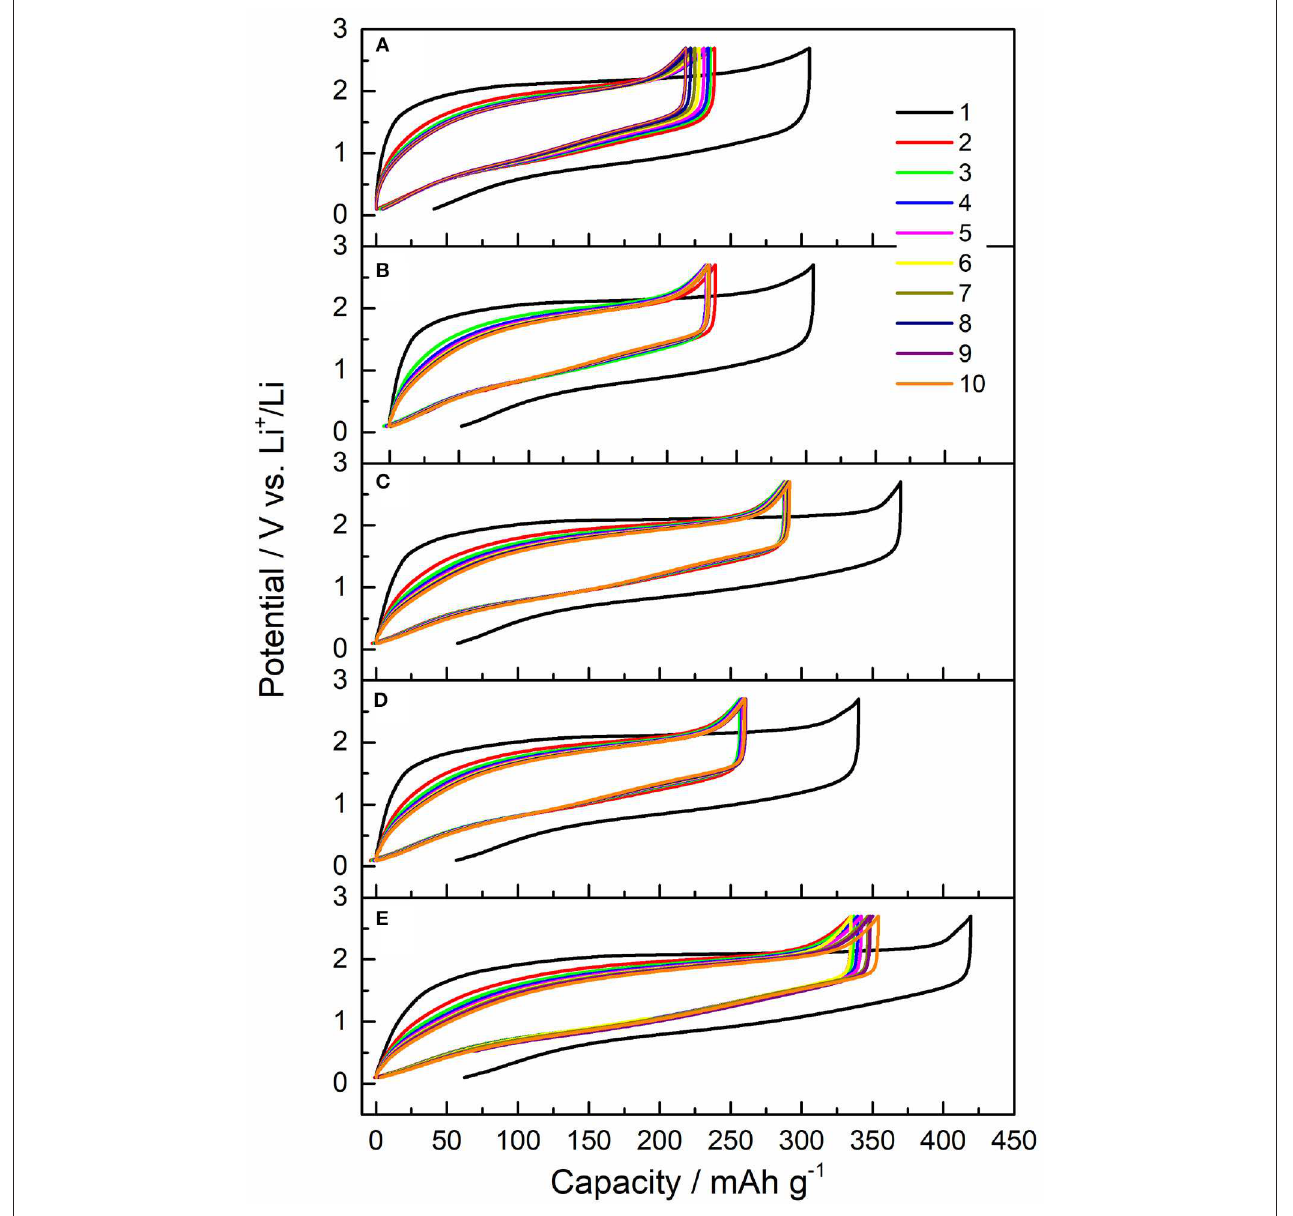
FIGURE 5 | The charge-discharge curves of initial 10 cycles for five samples, (A) I. Pristine LiBC, (B) II. 800-pellet, (C) III. 800-powder, (D) IV. 600-powder, and (E) V. 600-powder-Al, with a current of 0.05C and a voltage range of 0.1–2.7V.